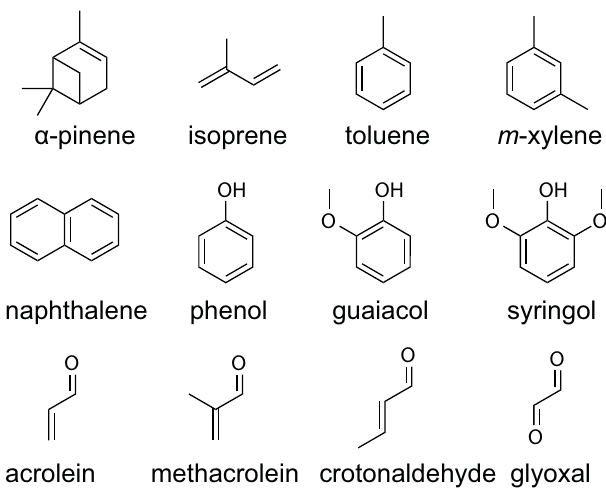
Fig. 1. Structures of the SOA precursors presented in this